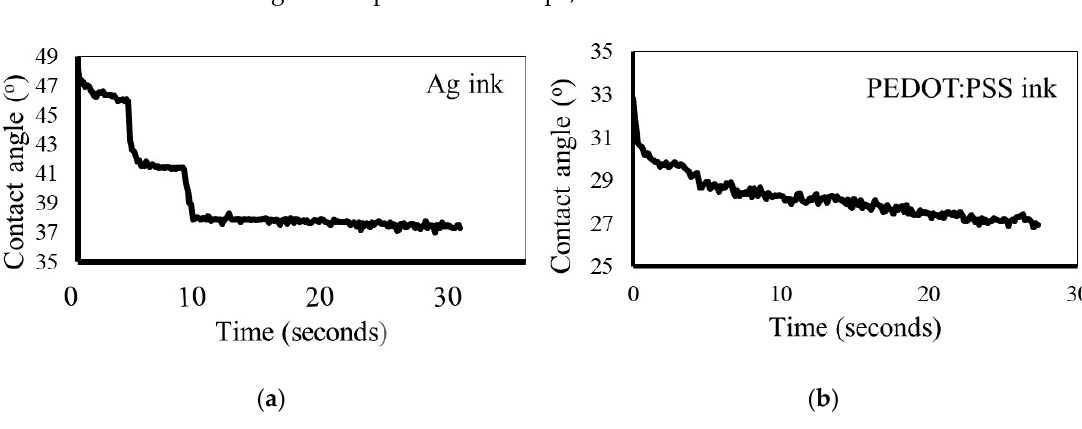
Figure 3. Contact angle versus time for the ( a ) Ag ink and ( b ) PEDOT:PSS ink on paper.